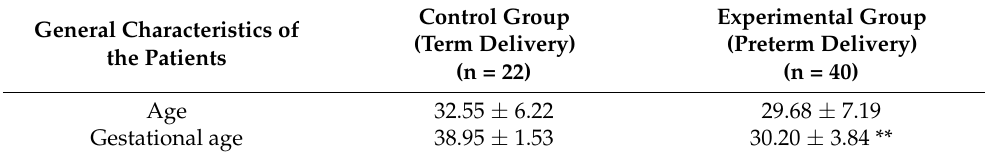
Table 1. General characteristics of the patients.